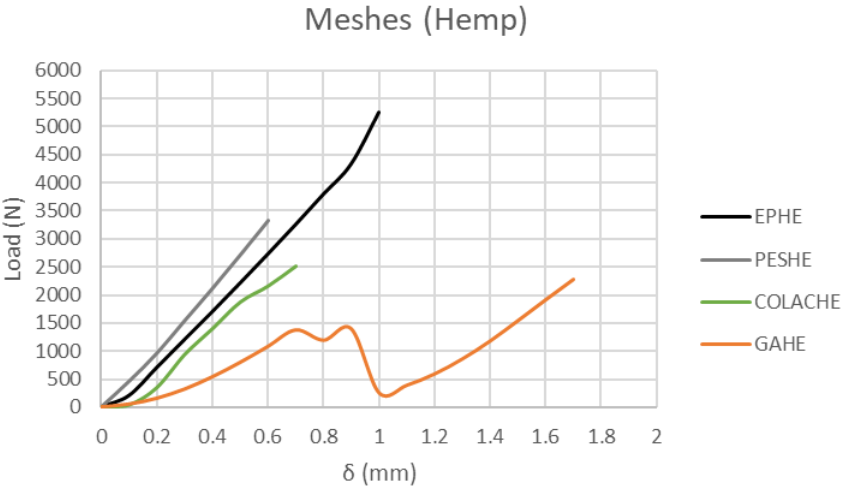
Figure 6. Load–Extensometer curves for hemp meshes. Figure 6. Load – Extensometer curves for hemp meshes.